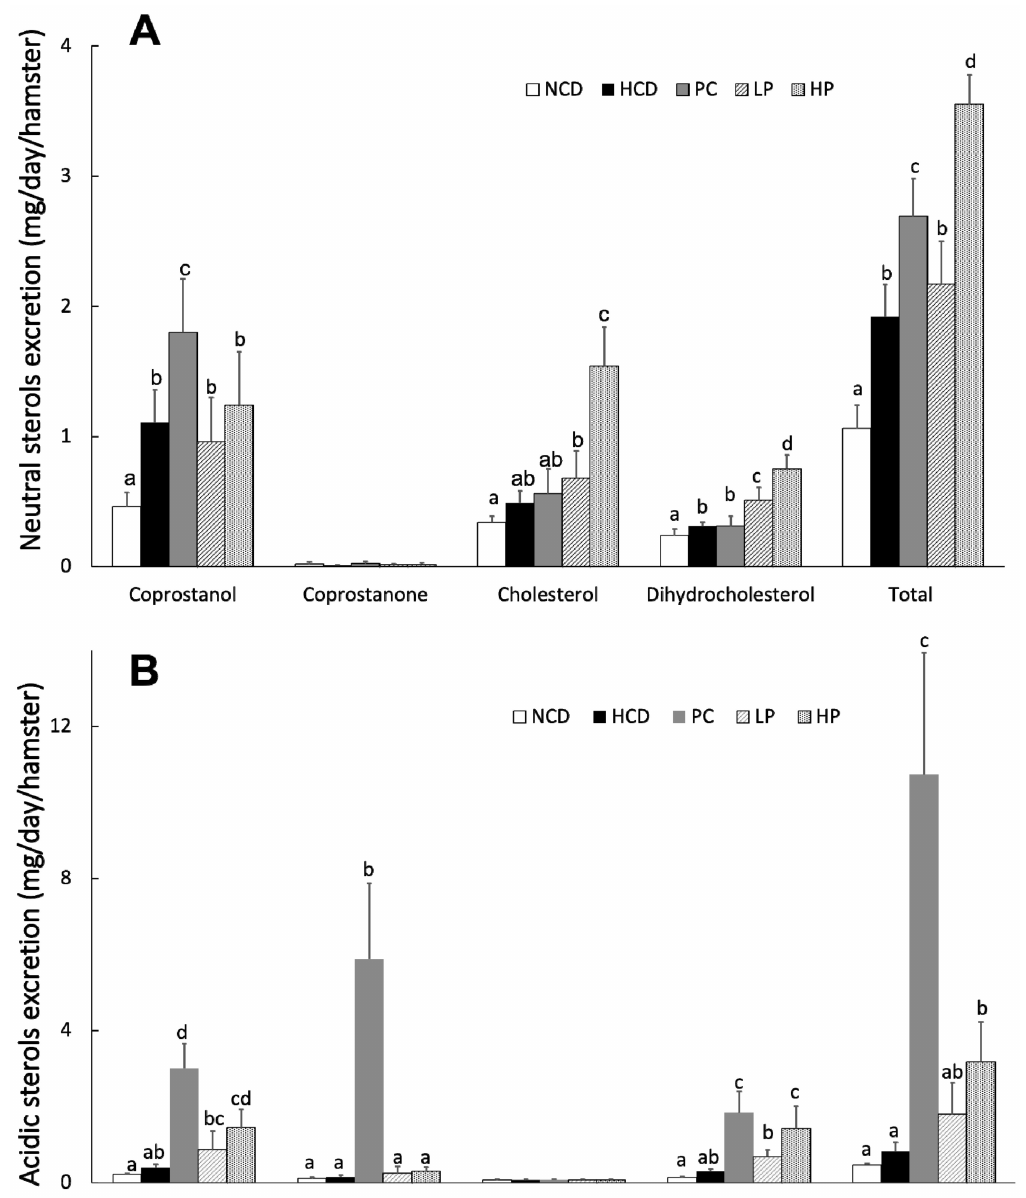
Figure 6. Daily fecal excretion of neutral sterols ( A ) and acidic sterols ( B ) at week 6 in hamsters fed one of five diets: NCD, no cholesterol diet; HCD, high cholesterol diet containing 0.1% cholesterol; PC, high cholesterol diet containing 0.5% cholestyramine; LP, high cholesterol diet containing a low dose (0.1%) soybean germ phytosterols (SGP); HP, high cholesterol diet containing a high dose (0.2%) soybean germ phytosterols (SGP). n = 8 for each group. a,b,c = means with di ff erent superscript letters di ff er significantly at p <